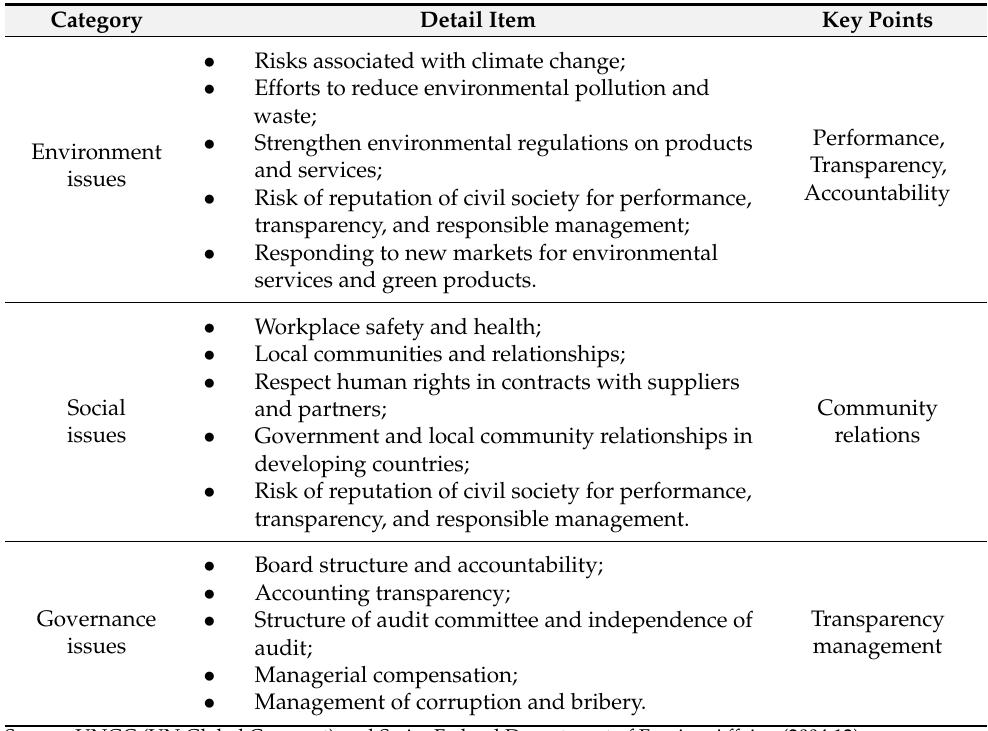
Table 1. ESG itemized initial concepts. Detail Item Key